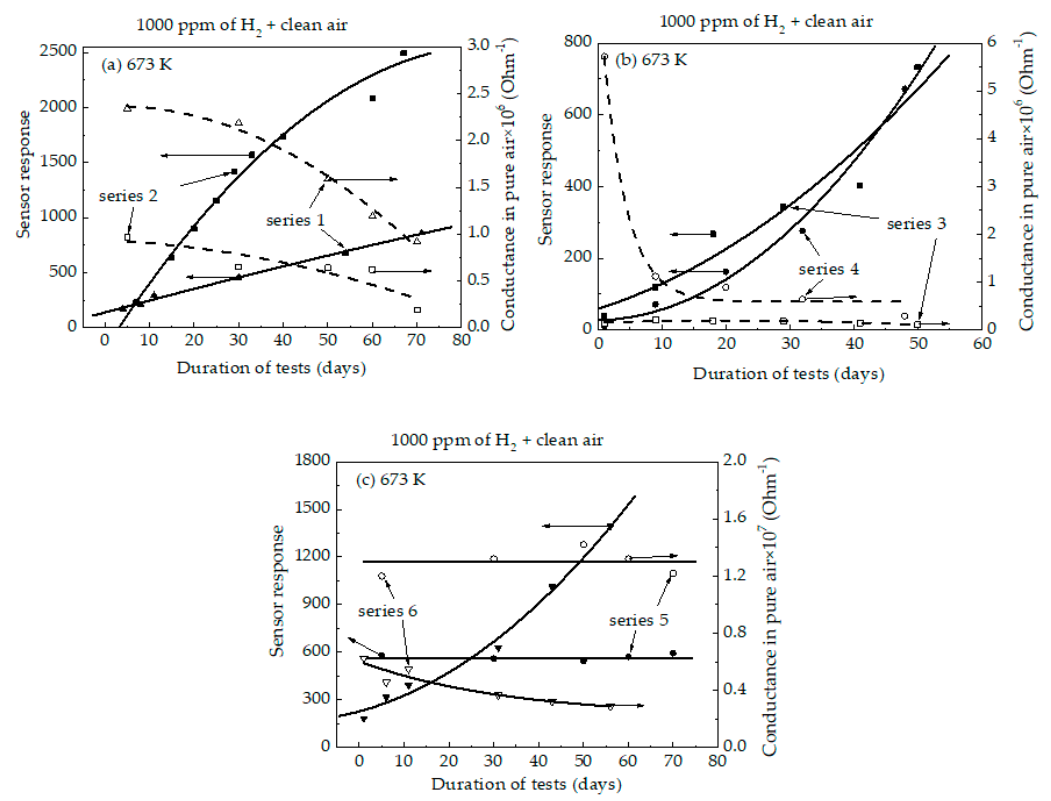
Figure 11. ( a – c ) The e ff ect of the duration of tests on the response to 1000 ppm of H 2